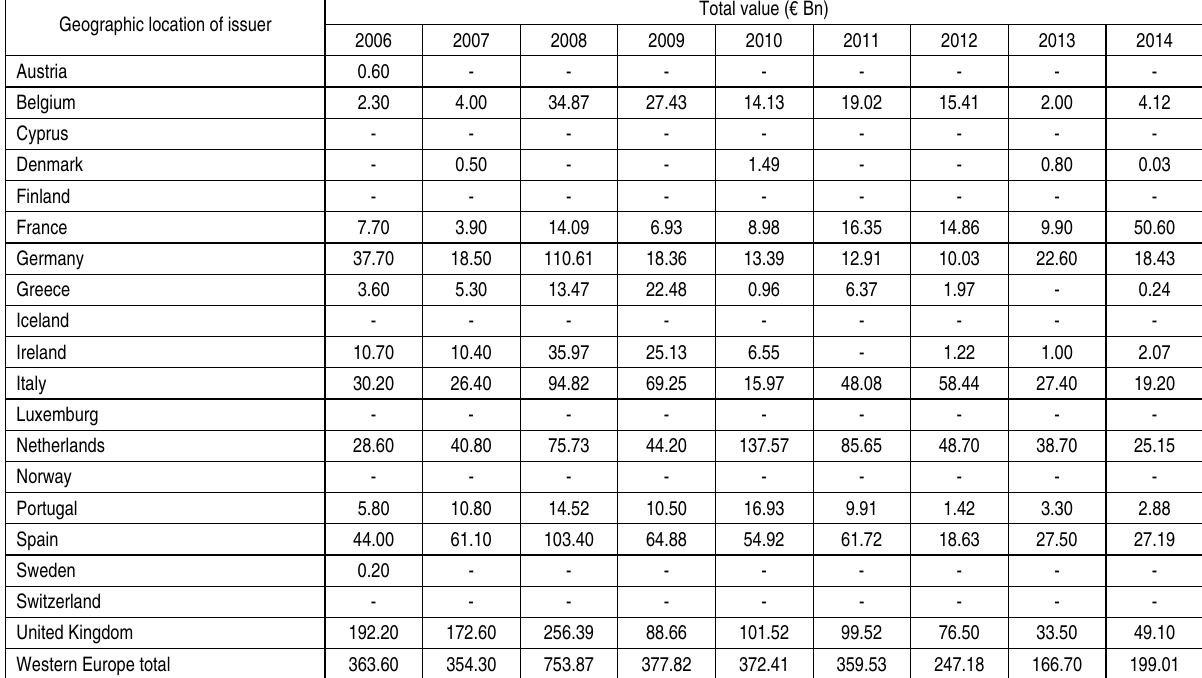
Table 5. Distribution of asset securitization bonds by year: Europe versus US Geographic location of